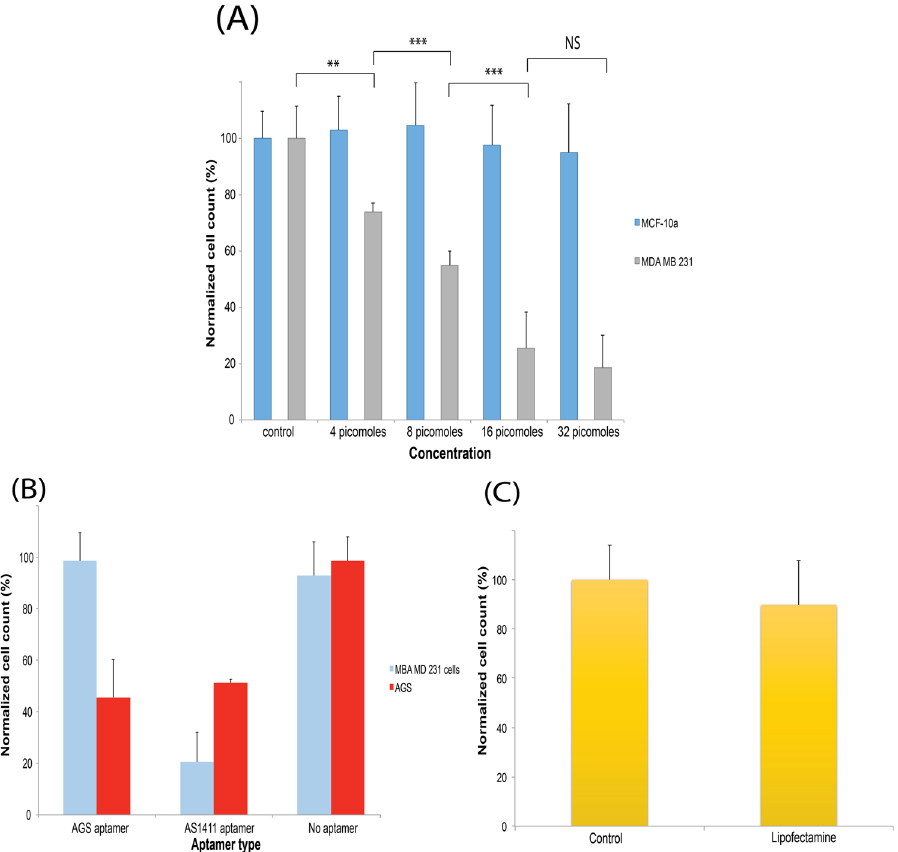
Figure 4. Apoptosis level on ( A ) MDA-MB 231 cells after 24 hours showing that at 32 pmoles, the nanoconstruct was able to induce cellular apoptosis of up to 82%. ( B ) 24 hour cell count from the incubation of the MDA-MB 231 and AGS cells with nanoconstruct that was constructed with the AGS-selective aptamer, AS1411 and when no aptamer was used. The absence of aptamer did not shown any appreciable reduction in numbers for both cells types. ( C ) 16 picomoles of single stranded antisense RNA was packaged with commercial lipofectamine 3000 and 231 cells were transfected without any notable changes in cell numbers after 24